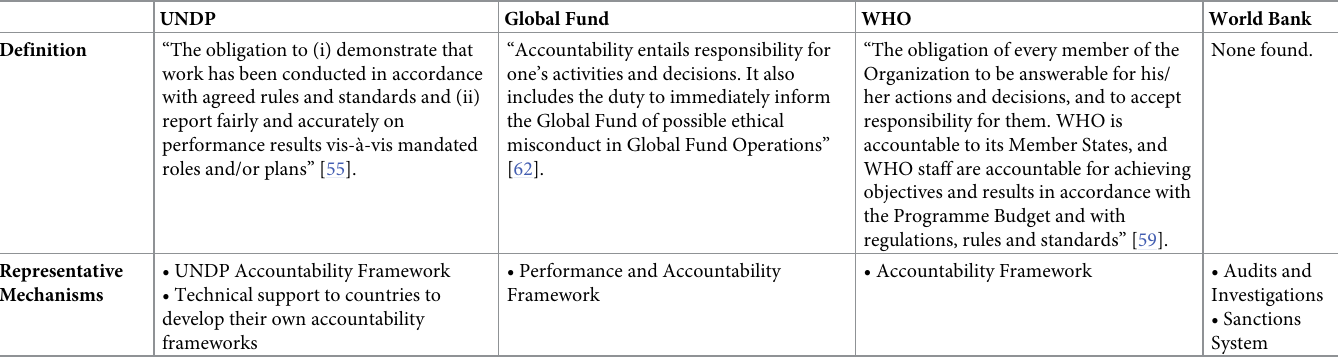
Table 4. Defining and operationalizing